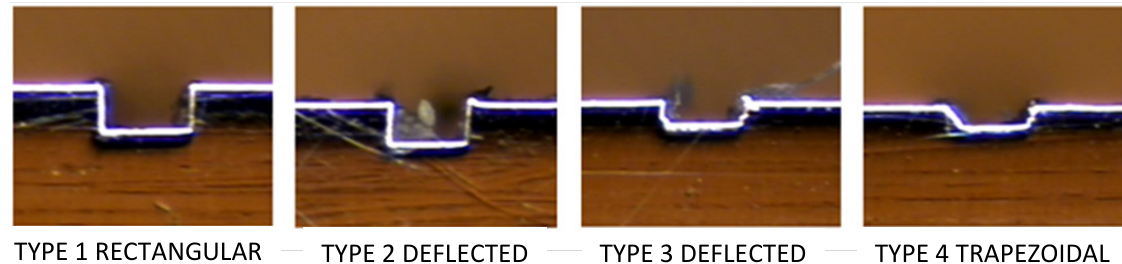
Figure 17. Common categorized profiles in AlSI 316L.